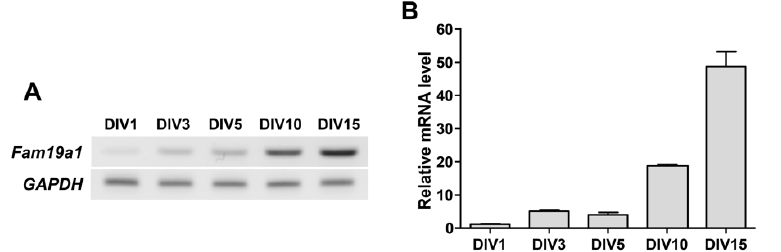
Figure 4. Fam19a1 expression across the days in vitro (DIV) progression in cultured primary hippocampal neurons. ( A ) Detection of Fam19a1 mRNA in primary hippocampal neurons. ( B ) Quantitative analysis of Fam19a1 mRNA across the DIV progression in primary hippocampal neurons. Each experimental group was analyzed in triplicate. Data are presented as means ± standard errors of means (SEM).